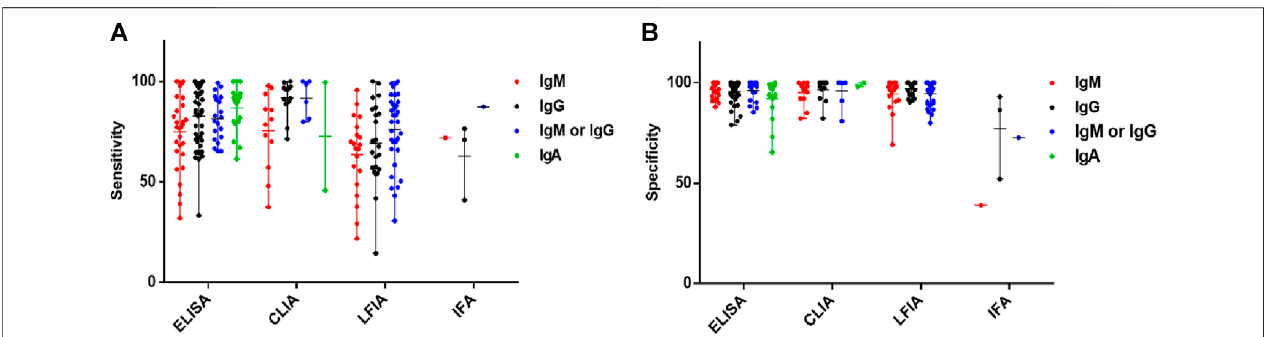
FIGURE 2 | Effectiveness of different serological diagnosis tests for anti-SARS-COV-2 antibodies. Sensitivity (A) and speci fi city (B) of ELISA, CLIA, LFIA, and IFA tests for anti-SARS-COV-2 IgM, IgG, and IgA.